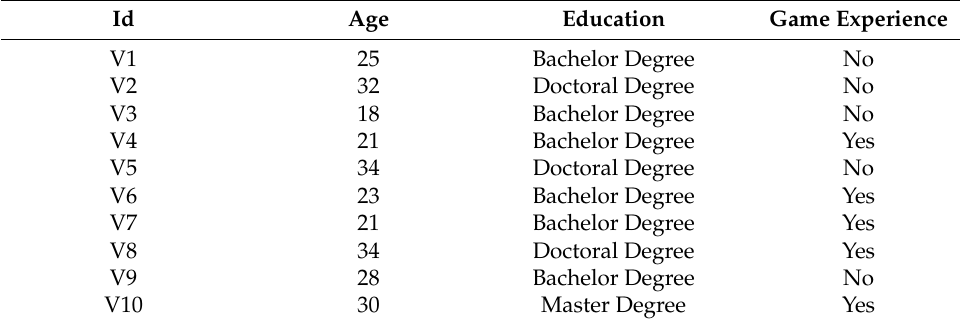
Table 4. Participant Information.